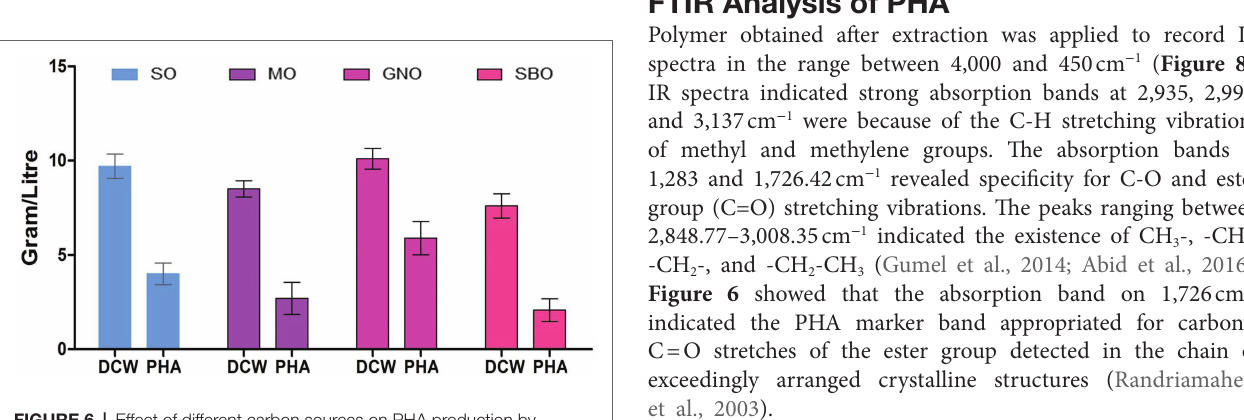
FIGURE 6 | Effect of different carbon sources on PHA production by P. aeruginosa EO1.